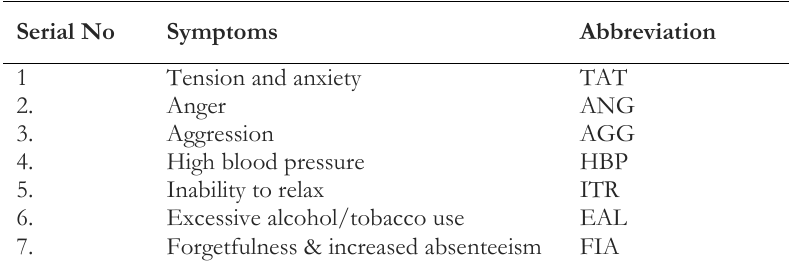
Table 1. Occupational Psychopathology (OCP) and the corresponding abbreviations